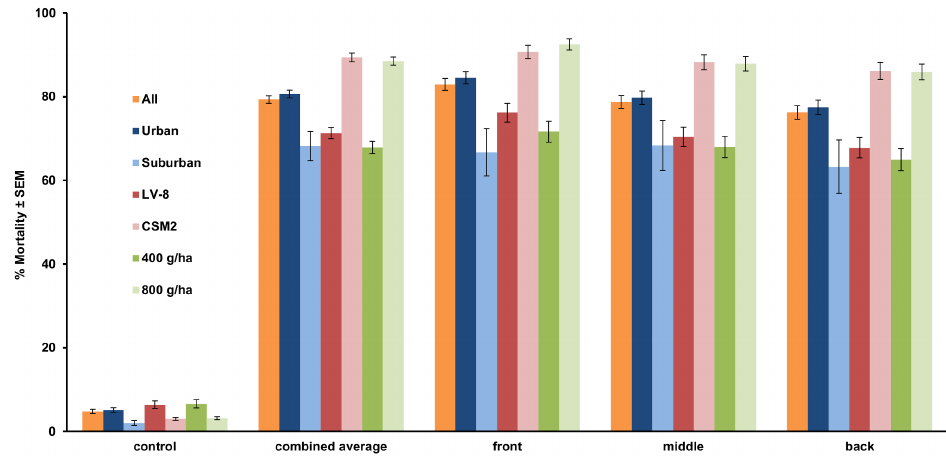
Figure 4. Efficacy by location of VectoBac WDG applied with a CSM2 and LV-8 at 400 and 800 g/ha in residential areas. Orange=average efficacy, dark blue=urban plots, light blue=suburban plots, red=LV-8, pink=CSM2, dark green=400 g/ha, light green=800 g/ha.